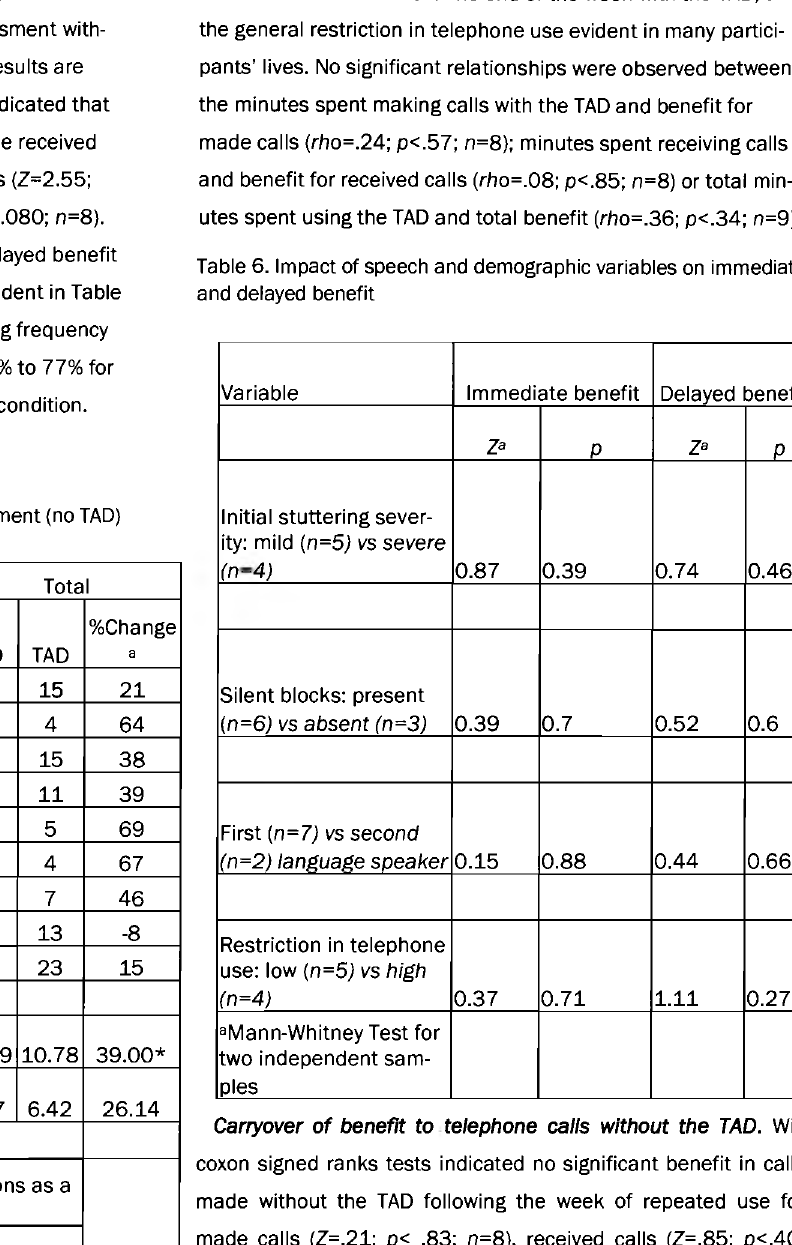
Table 5. Delayed benefit from TAD: from initial assessment (no TAD) to final (TAD) assessment